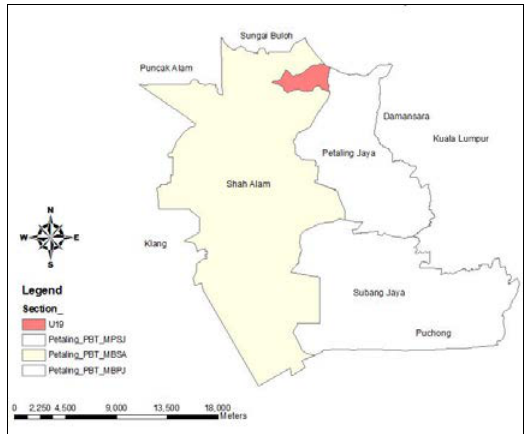
Figure 1. Location of the study area, Section